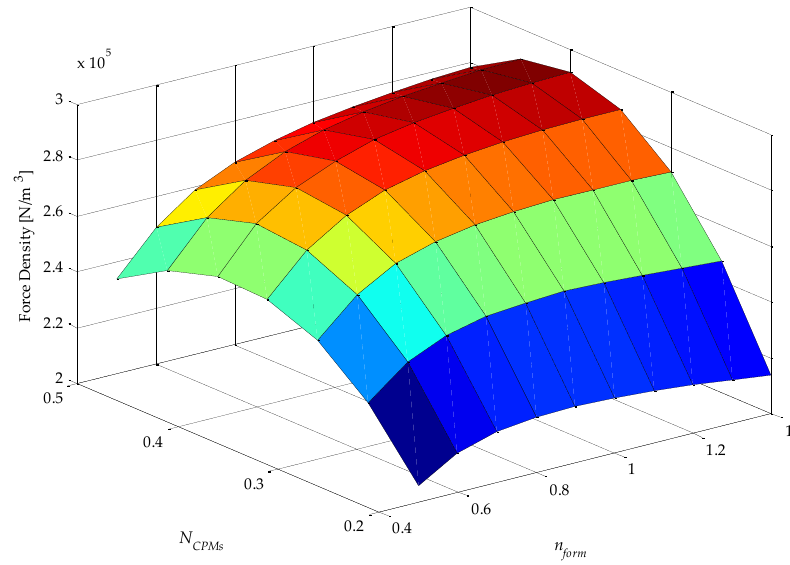
Figure 5. 3D graph with results of force density of the uncoupled design for two parametric variables: N CPMs and n form . Results for J rms = 3 A/mm 2 , θ e = π/6 , τ r / τ p = 0.75, and N PMi = 0.60.